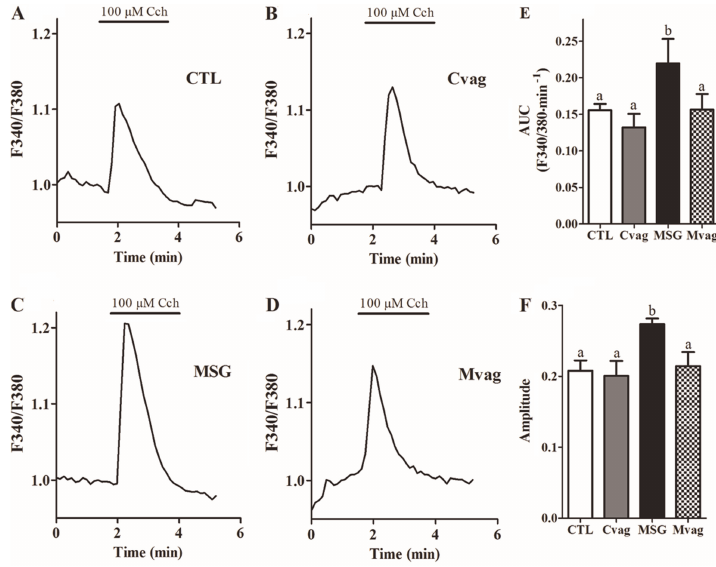
Figure 4. Representative curves of glucose-induced cytoplasmic Ca 2++ oscillations in islets isolated from 90-day-old CTL ( A ), Cvag ( B ), MSG ( C ) and Mvag ( D ) rats. The area under the curve (AUC) (during G16.7 condition=5-20 min) ( E ), frequency of Ca 2++ oscillations ( F ) and amplitude ( G ) of the [Ca 2++ ]i in response to 16.7 mM glucose. The experiments were performed in a perifusion system in a medium that contained 2.8 or 16.7 mM glucose (G2.8 and G16.7, respectively). The amplitude was calculated by subtracting the highest fluorescence ratio obtained at G16.7 from G2.8 fluorescence values immediately before changing the glucose concentration in the perifusion. Data are the ratio of F340/F380 registered for each group. CTL: control; Cvag: CTL with subdiaphragmatic vagotomy; MSG: monosodium glutamate; Mvag: MSG with subdiaphragmatic vagotomy. Data are reported as means±SE that were obtained from 4-14 independent experiments. Different letters represent statistically significant differences (two-way ANOVA followed by Duncan’s post-test, P # 0.05).